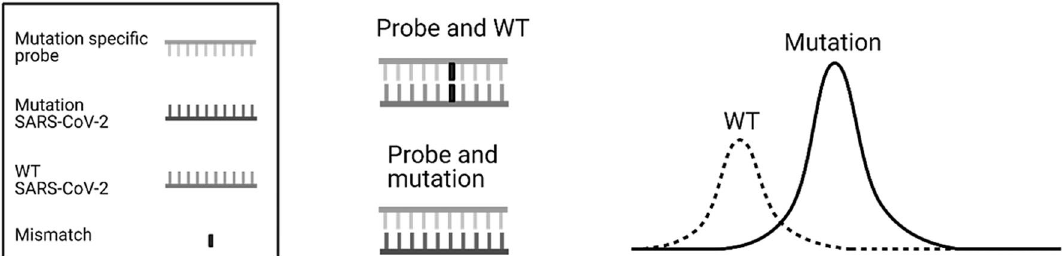
Figure 1. Created with BioRender.com The binding of the wild type and mutation sequence to the mutation specific probe. The probe has higher affinity for the mutation sequence and will result in a higher melting point temperature (Tm). The probe has a lowered affinity for the WT sequence due to the single nucleotide mismatch resulting in a decreased variations can increase the binding affinity to the ACE2 receptor 9 , thereby increasing viral transmission 10 . S protein variation also affects the binding of antibodies generated in response to infection with the SARS-CoV-2 strains and antibodies induced by vaccines based on the original S gene sequence affecting their ability to neutralize the virus 11 . The S gene variations give rise to SARS-CoV-2 variants of interest (VOI) and variants of concern (VOC) e.g. the distinct variants B.1.1.7 (Alpha), B.1.351 (Beta), P.1 (Gamma) and B.1.617.2 (Delta) that have increased infectivity and reduced neutralization by antibodies induced by SARS-CoV-2 vaccines 12,13 . This increased infectivity is in part due to specific amino acid changes such as K417N/T, N439K, E484K, N501Y and P681H caused by single nucleotide polymorphisms (SNPs) in the S-gene 14 . In order to contain, prevent or